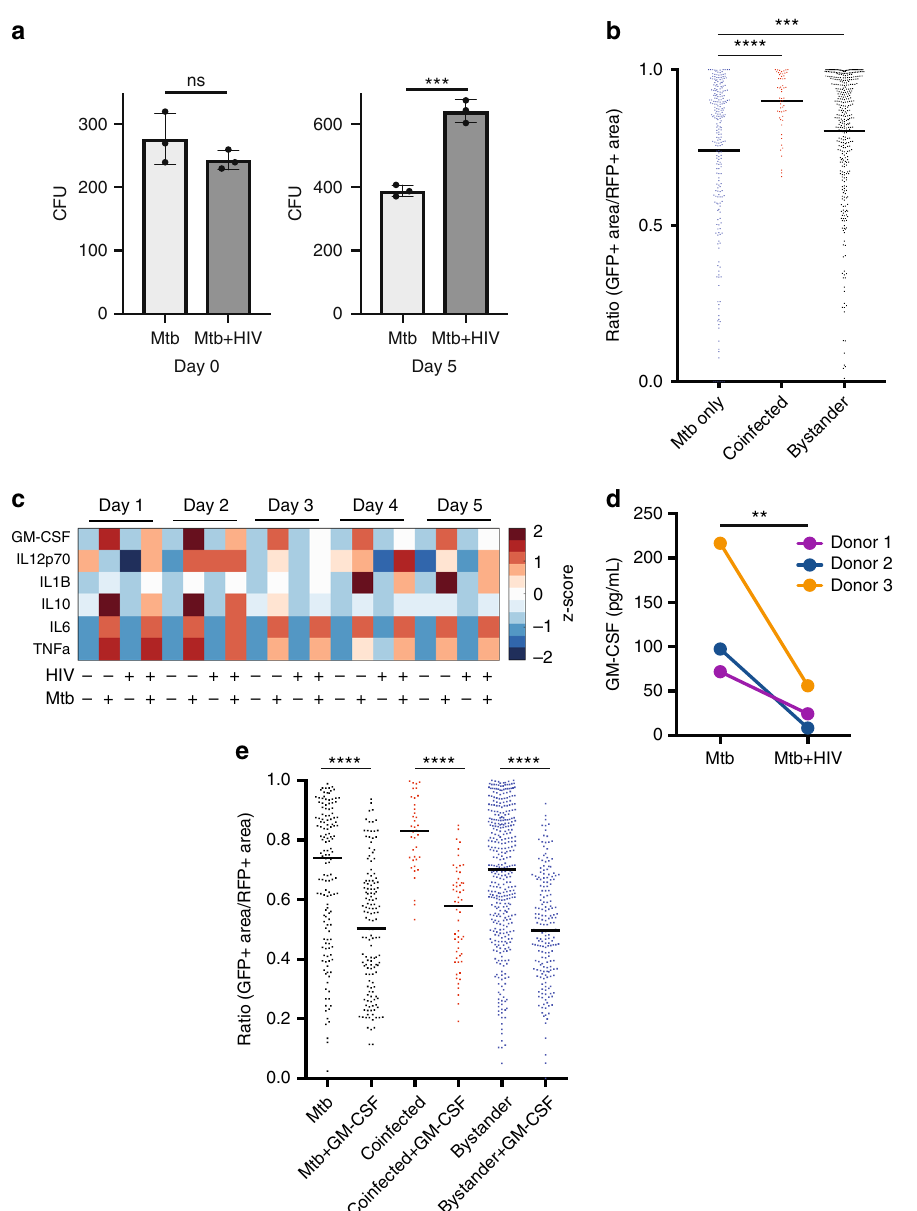
Fig. 4 HIV coinfection disrupts macrophage control of Mtb and disrupts GM-CSF signaling. a One of two paired human MDM cultures was coinfected (infected with HIV and subsequently Mtb (Mtb + HIV)), while the other was infected with Mtb only. Uptake and growth of Mtb was compared using colony-forming units (CFU) at Day 1 and Day 5 post-infection, respectively. Error bars represent standard error from technical replicates. Comparisons made using a two-tailed t -test. Representative donor of four. b Mtb-infected macrophages were scored 5 days post-infection based on the percentage of transcriptional activity of the resident Mtb at various times post-infection. Dots represent data from an individual macrophage. Black lines represent the median. Comparisons made using the Mann-Whitney test. Representative of six donors. c Multiplex analysis of GM-CSF, IL-12, IL-1 β , IL-10, IL-6, and TNF α secretion was measured and compared between uninfected, HIV only, Mtb-only and co-infected cultures at various times post-Mtb infection. d The secretion of GM-CSF 1 day post-infection was compared between paired Mtb-only and coinfected cultures. Three independent experimental donors are represented. Comparisons made using a paired two-tailed t -test. e Mtb-infected macrophages were scored 4 days post-infection based on the percentage of transcriptional activity of the resident Mtb and compared to paired co-infected cells, with or without treatment with GM-CSF. Dots represent data from an individual macrophage. Black lines represent the median. Representative donor of six. Comparisons made using the Mann – Whitney test. (ns = not signi fi cant, ** p < 0.01, *** p < 0.001, **** p < 0.0001). Source data are provided as a Source Data fi HIV as compared to HIV uninfected cells (Fig. 4a). We positive for p24 and Mtb (coinfected macrophages) and mac- assessed the effect of HIV infection on macrophage control of rophages that were negative for p24 and positive for Mtb the bacteria at a single cell level using the live-dead Mtb (bystander macrophages) were both signi fi cantly more per- reporter strain and p24 immuno fl uorescence to identify mac- missive of Mtb survival than macrophages not exposed to HIV rophages supporting HIV replication. Macrophages that were (Fig. 4b).